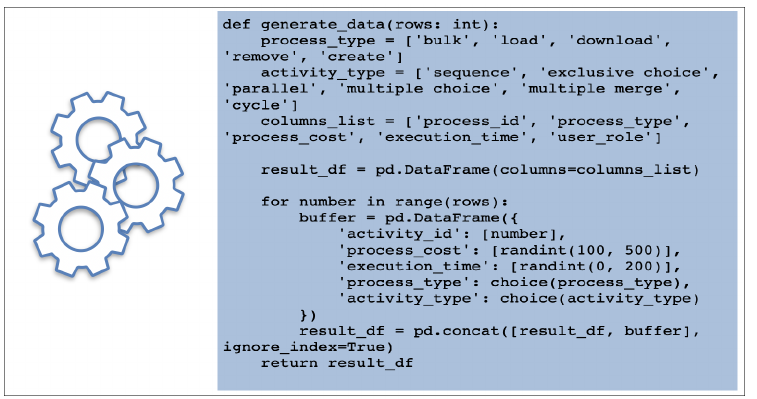
Figure 12. Generate simulated BP data.